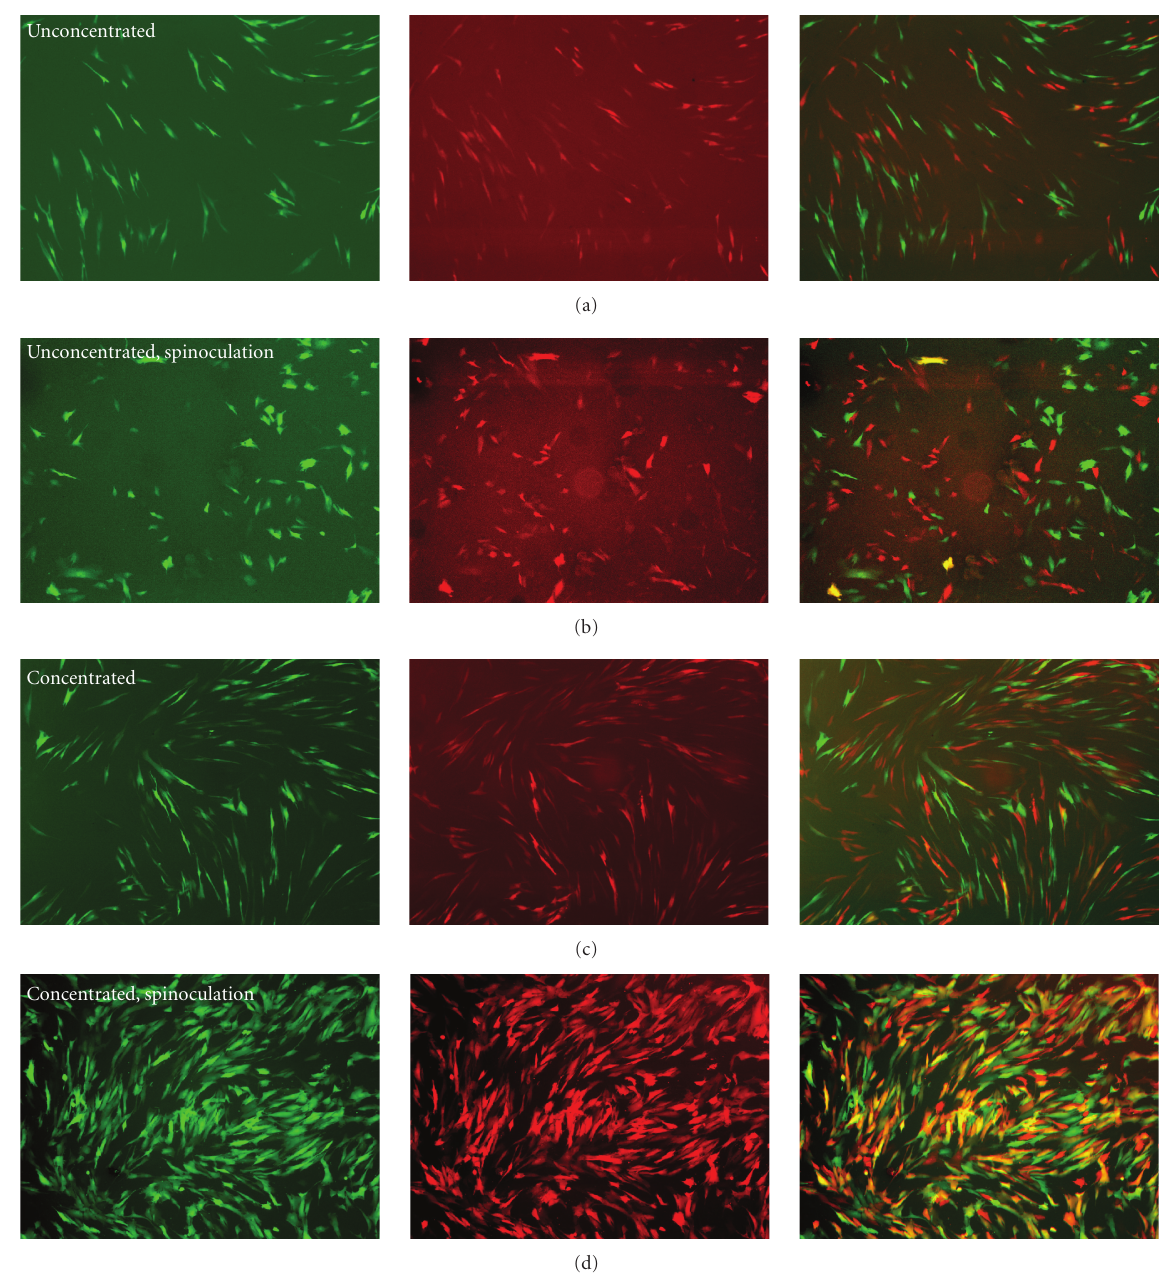
Figure 2: Visualization of coinfection using green and red fluorescent proteins. CRL-2703 human fibroblasts were infected with a 1 : 1 mixture of amphotropic retroviral vectors encoding EGFP and dsRed2. Vectors were used unconcentrated (maximal volume for a well of a 6-well plate: total 7 ml); the same with spinoculation at 1200g, 15 ◦ C, 2 hours; concentrated by flocculation with Polybrene from 16 sets of Plat-A cell plates; or combined concentration with Polybrene and spinoculation. Cells were photographed 4 days after infection. Green and red images of representative fields of cells (left and middle) were merged (right) to show coinfected cells